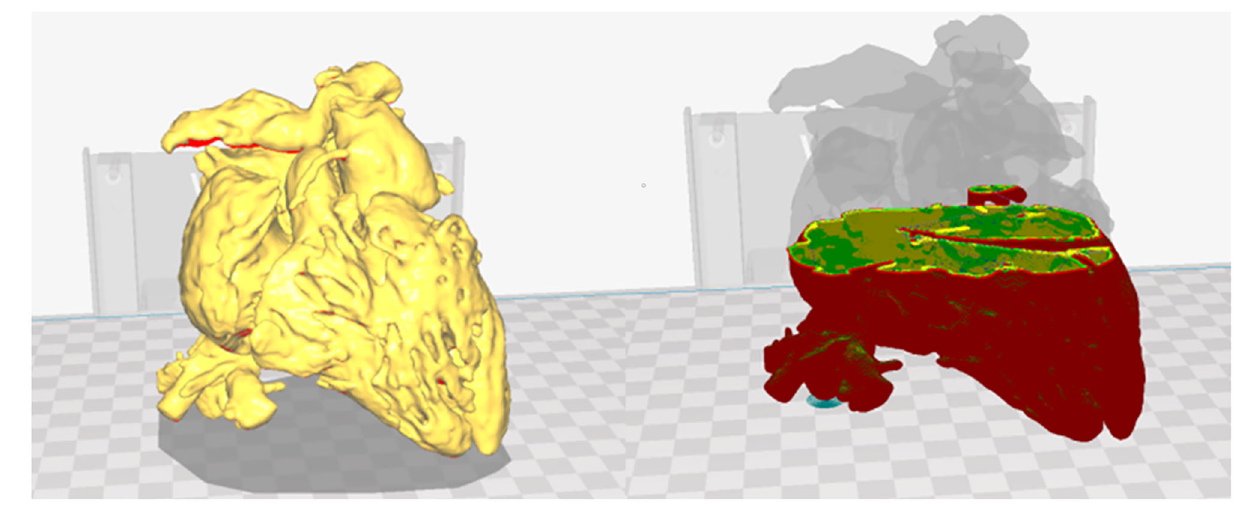
FIGURE 3 | Printing parameters in Cura. Heart model visualization in Cura and virtual simulation of the printing process. Red: external layer; yellow: medium layer; and green: internal layer.